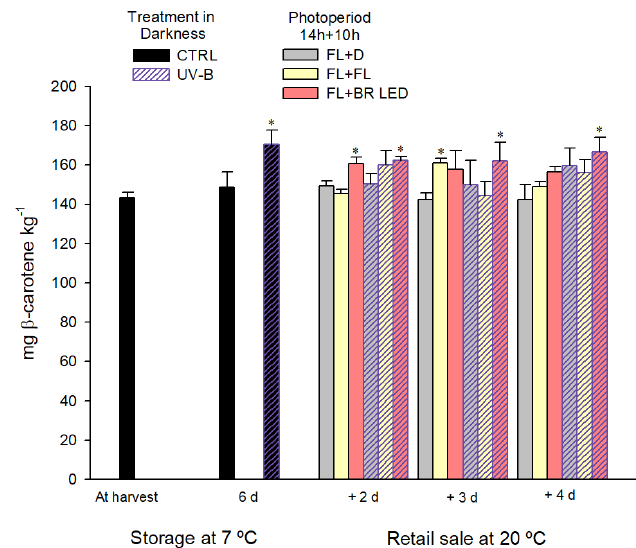
Figure 4. Total capsanthin content of UV-B-treated and untreated CTRL bell peppers after 6 d at 7 °C followed by a retail sale period of 2, 3, and 4 d at 20 °C under different lighting conditions. *: significant differences compared to CTRL. Treatment in darkness (T): CTRL (non-striped bars) and UV-B (striped bars); Photoperiod during retail sale (P): FL + D (grey bars), FL + FL (yellow bars), FL+BR LED (light red bars); and time (t). LSD T = n.s.; LSD P = (4.577) †† ; LSD t = n.s.; LSD T × P = n.s.; LSD T × t = (6.473) † ; LSD P × t = n.s.; LSD T × P × t = (11.211) ††† . n.s.: no significant; † : p > 0.05; †† : p > 0.005; ††† : p > 0.001.